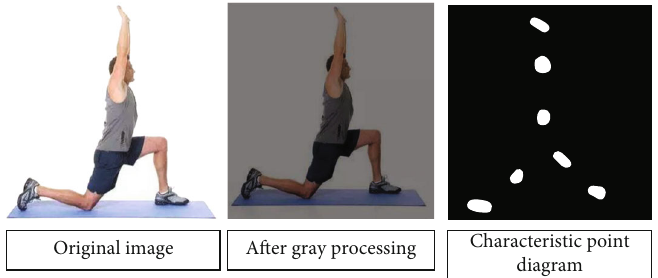
Figure 2: Comparison between original image and image after automatic tracking feature point recognition.